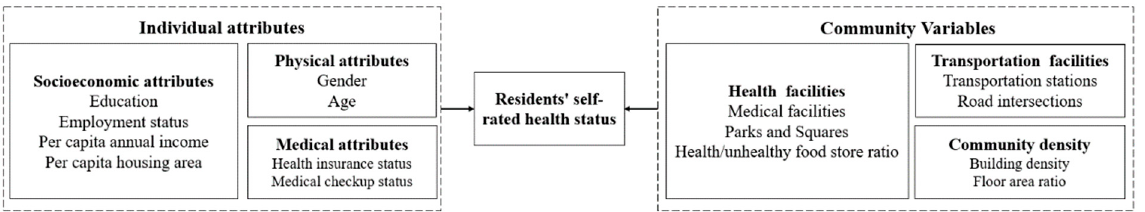
Figure 2. Research framework of the influence of personal attributes and community environment on residents’ self-rated health status.